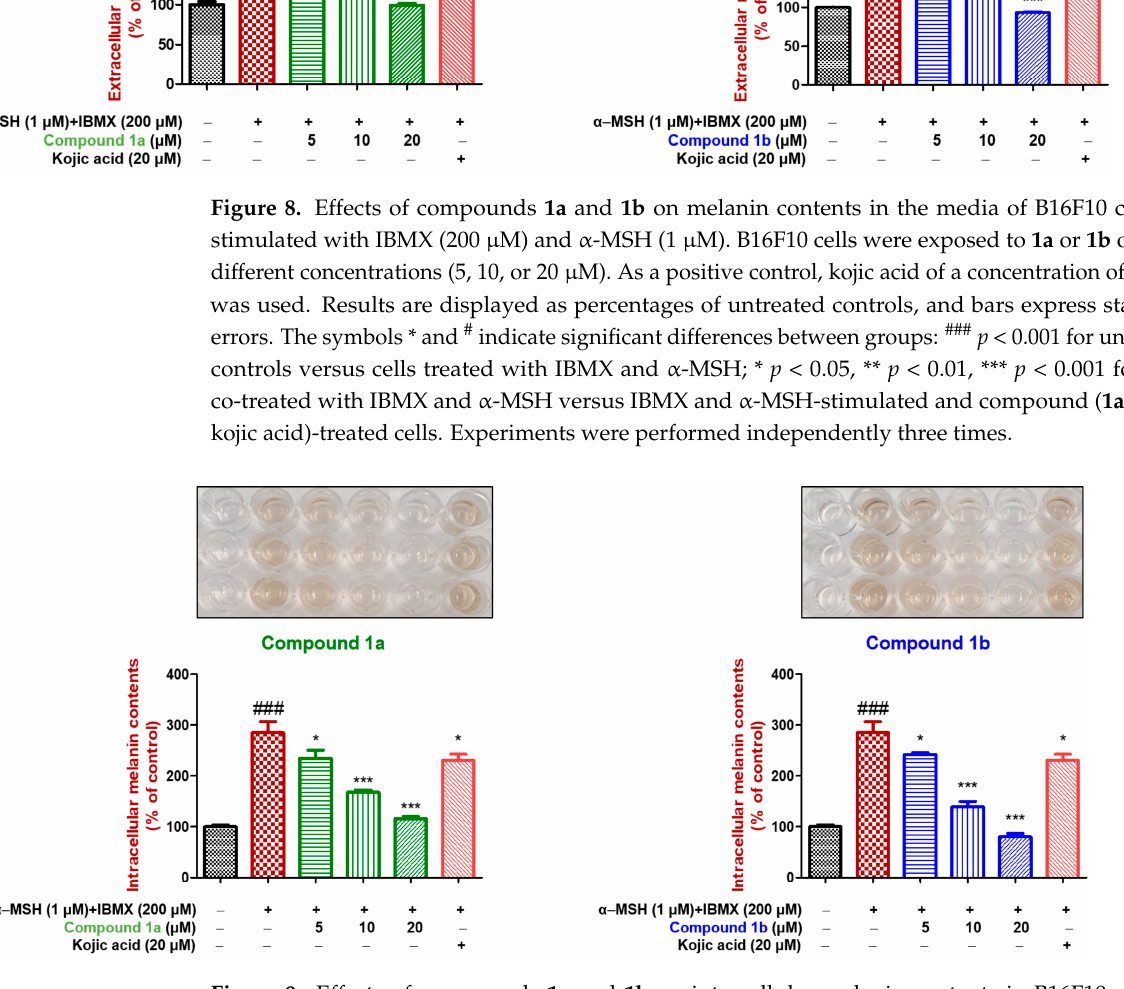
Figure 9. Effects of compounds 1a and 1b on intracellular melanin contents in B16F10 cells co-stimulated with IBMX and α -MSH. B16F10 cells were exposed to 1a or 1b at three concentrations (5, 10, or 20 μ M). As a positive control, kojic acid of 20 μ M was used. Results are displayed as percentages of untreated controls, and bars mean standard errors. The symbols * and # indicate significant differences between groups: ### p < 0.001 for untreated controls versus cells co-treated with IBMX and α -MSH; * p < 0.05, *** p < 0.001 for cells co-treated with IBMX and α -MSH versus cells co-treated with IBMX and α -MSH and compound 1a , 1b , or kojic acid. Experiments were independently conducted three times.